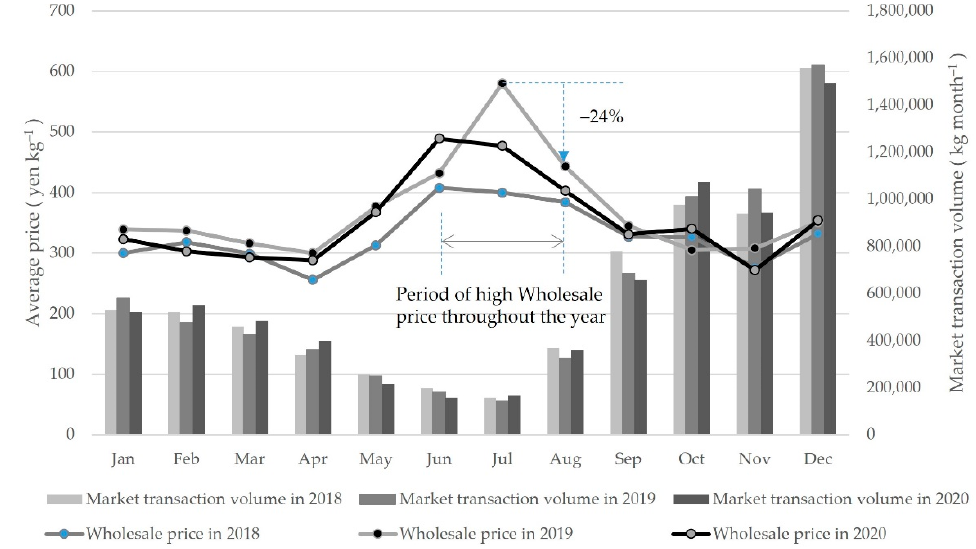
Figure 9. Monthly market transaction volume and average wholesale price of taro in the Tokyo Central Wholesale Market for the past three years (Adapted with permission from Ref. [59]. 2022, Metropolitan Central Wholesale Market of Japan).